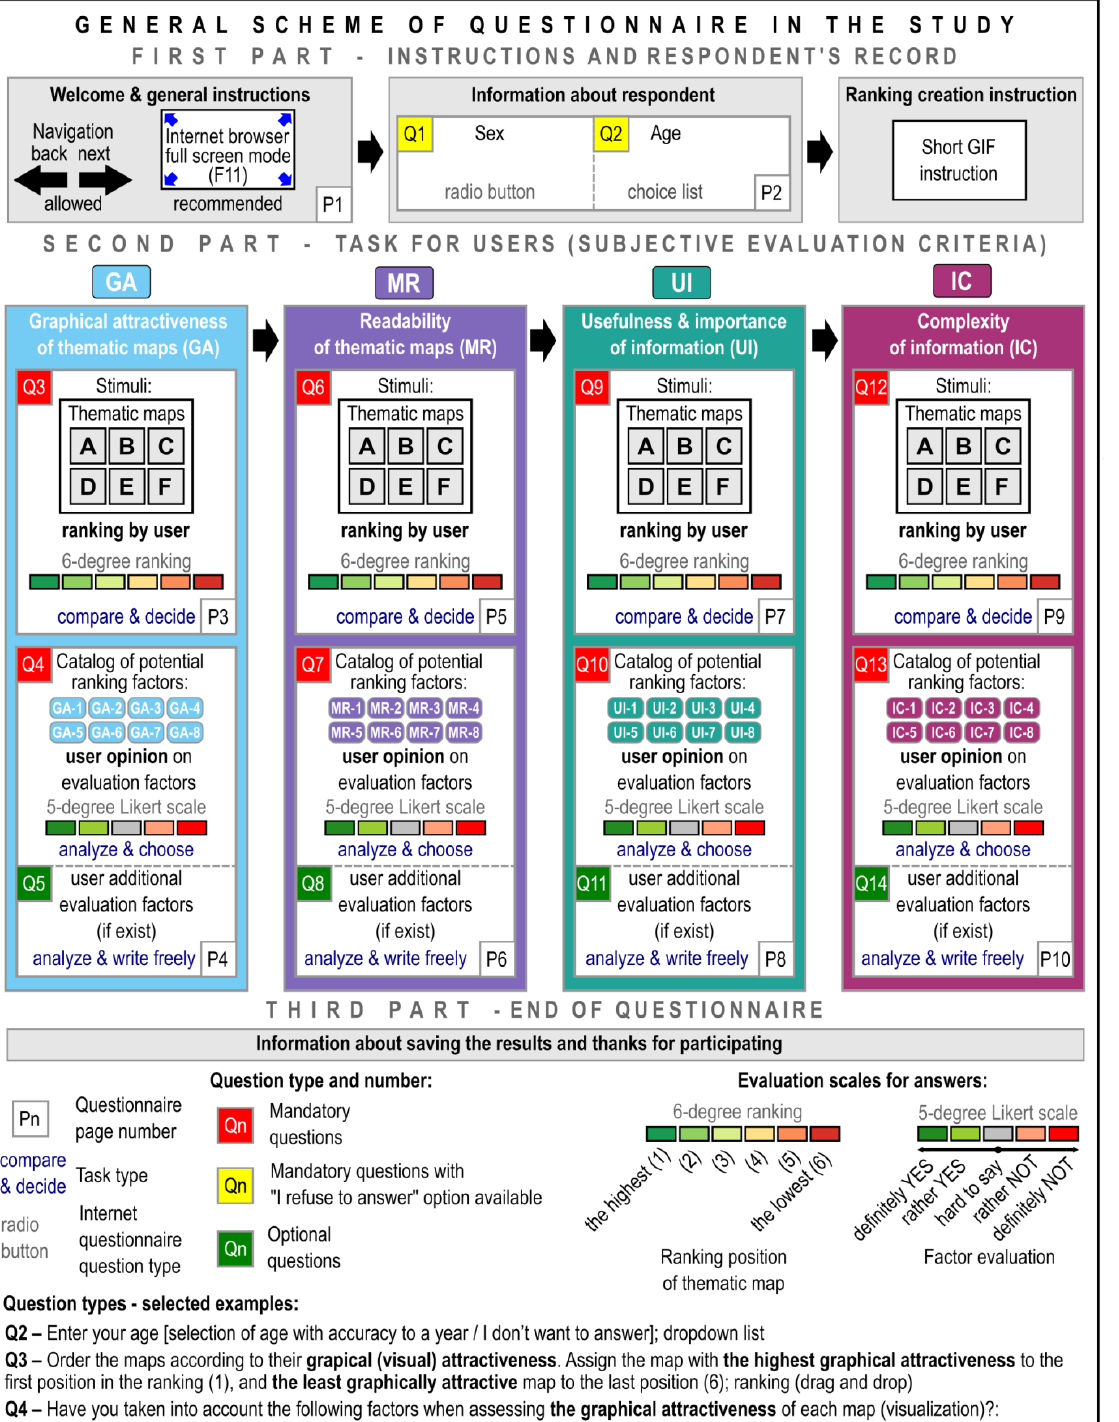
Figure 3. Scheme of the survey — the construction of the online questionnaire used in the study.